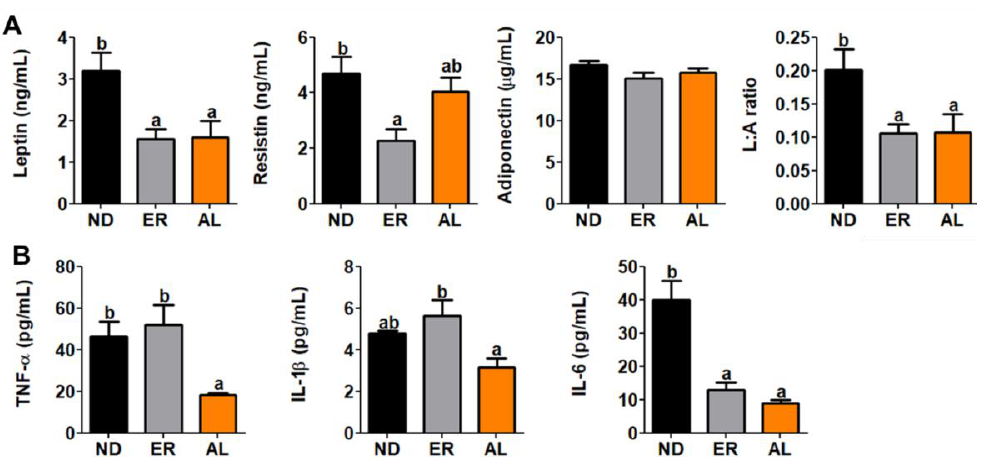
Figure 5. E ff ect of AL supplementation for 16 weeks on plasma ( A ) adipokine / ( B ) cytokine levels Figure 5. Effect of AL supplementation for 16 weeks on plasma ( A )adipokine/( B )cytokine levels in in C57BL / KsJ-db / db mice. Data are mean ± S.E. a b Means values with unlike superscript letter C57BL/KsJ-db/db mice.